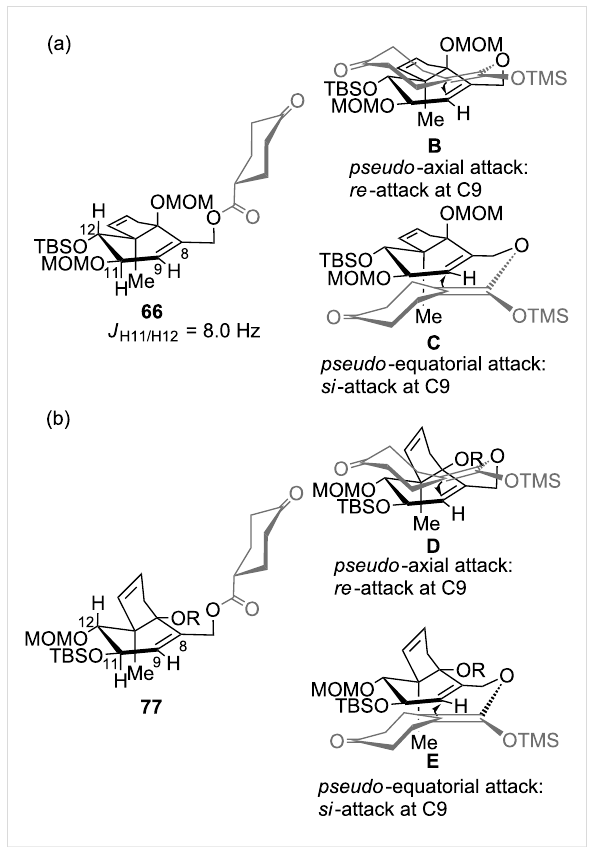
Figure 3: Conformations of rearrangement precursors 66 and 77 and possible transition states involved in the Ireland–Claisen rearrange- ments. R =